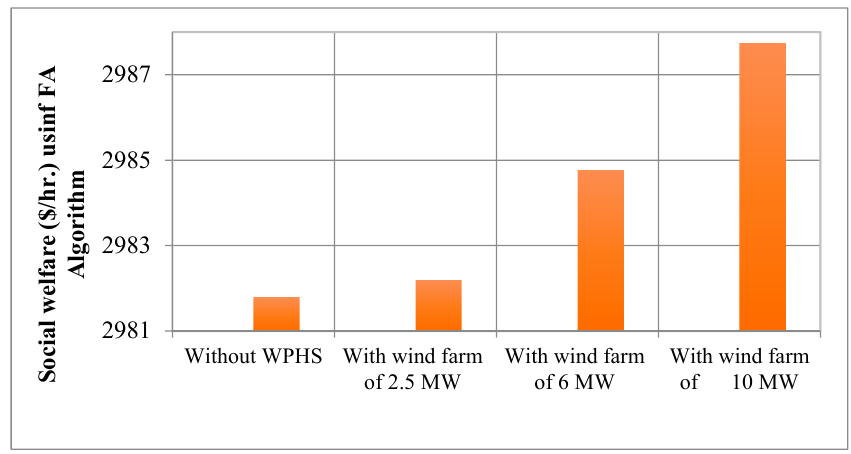
Figure 13. Comparison of social welfare using FA algorithm.